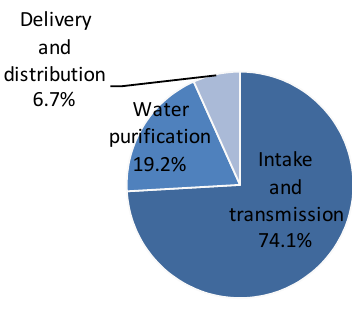
Figure 4. Breakdown of energy consumption for waterworks in Japan.